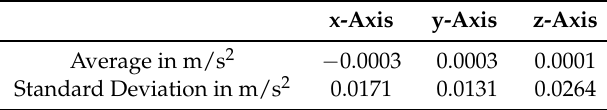
Table 9. Linear accelerometer measurements.